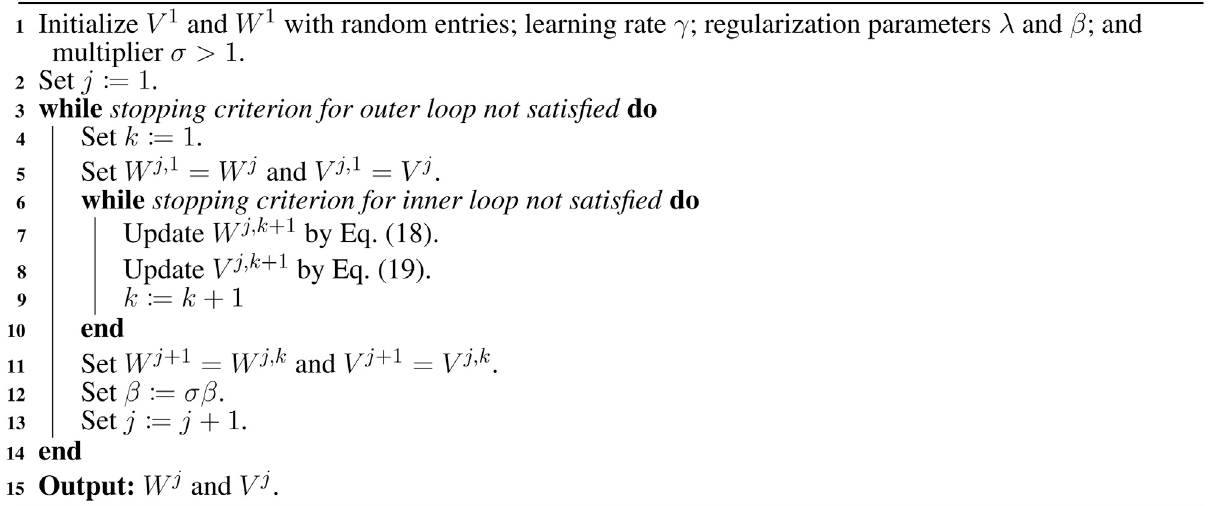
Algorithm 1: Algorithm for Nonconvex Sparse Group Lasso